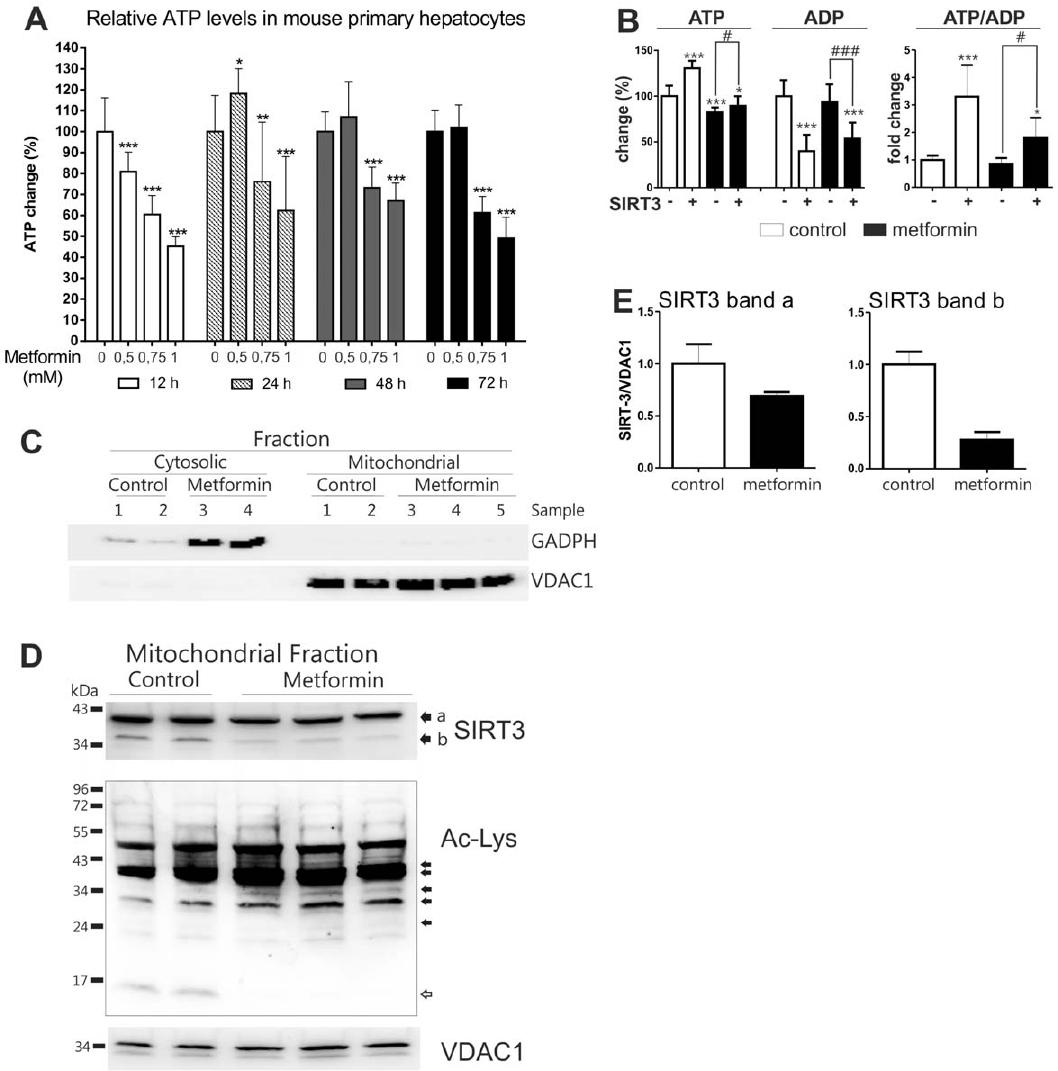
Figure 3. Metformin reduces ATP synthesis and mitochondrial SIRT3 expression and affects mitochondrial acetylation. A) Effect of metformin on cellular ATP level. Mouse primary hepatocytes were treated with metformin and ATP levels were measured at indicated time points. Data are presented as mean + SD (n=12). Statistical significance to 0 mM metformin samples at each time point *P , 0.05, ** P , 0.01,*** P , 0.001 (ANOVA, Bonferroni post hoc test). B) HepG2 cells were transfected either with SIRT3 plasmid or pcDNA3 control plasmid for 24 hours and treated with 3 mM metformin for an additional 24 hours. Thereafter the cells were collected, ATP and ADP measured and the ATP/ADP ratio calculated. In each case, values are presented relative to untreated samples (without SIRT3). Data is presented as mean + SD (n=12). Statistical significance to control samples (without SIRT3) *P , 0.05, *** P , 0.001; statistically significant differences of pcDNA3 and SIRT3 samples treated with metformin # P , 0.05, ### P , 0.001, (ANOVA, Bonferroni post hoc test). C) Evaluation of mitochondrial fraction integrity. Mouse primary hepatocytes were treated with 1 mM metformin for 72 hours. Cytosolic and mitochondrial fractions from the same samples were isolated and subjected to Western blot analysis. D) Metformin affects SIRT3 expression and mitochondrial protein acetylation. Western blot analysis of the same mitochondrial fractions as in fig. 3C. Upper panel: immunostaining with anti-SIRT3 antibody, middle panel: immunostaining with anti-acetyl lysine antibody and lower panel: VDAC1 was detected as a loading control. Closed arrows indicate proteins hyperacetylated by metformin treatment, an open arrow indicates a protein deacetylated by metformin treatment. E) Quantitation of SIRT3 intensity in Western blot shown in fig. 3D (upper panel). Bands a and b were quantified separately and normalized to VDAC1.